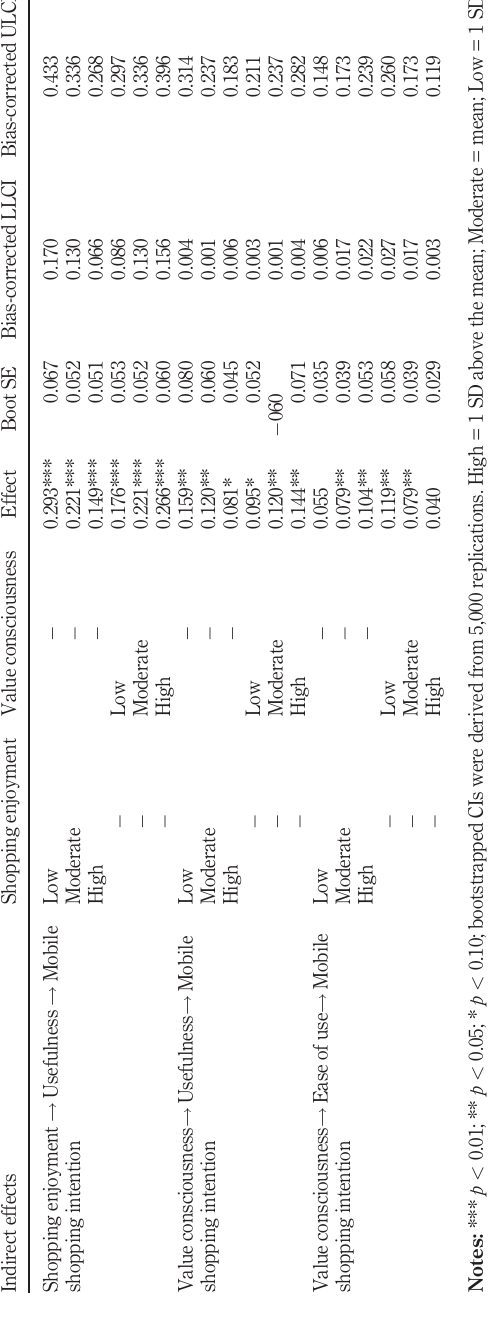
Table 2. Test of indirect effects on m- shopping